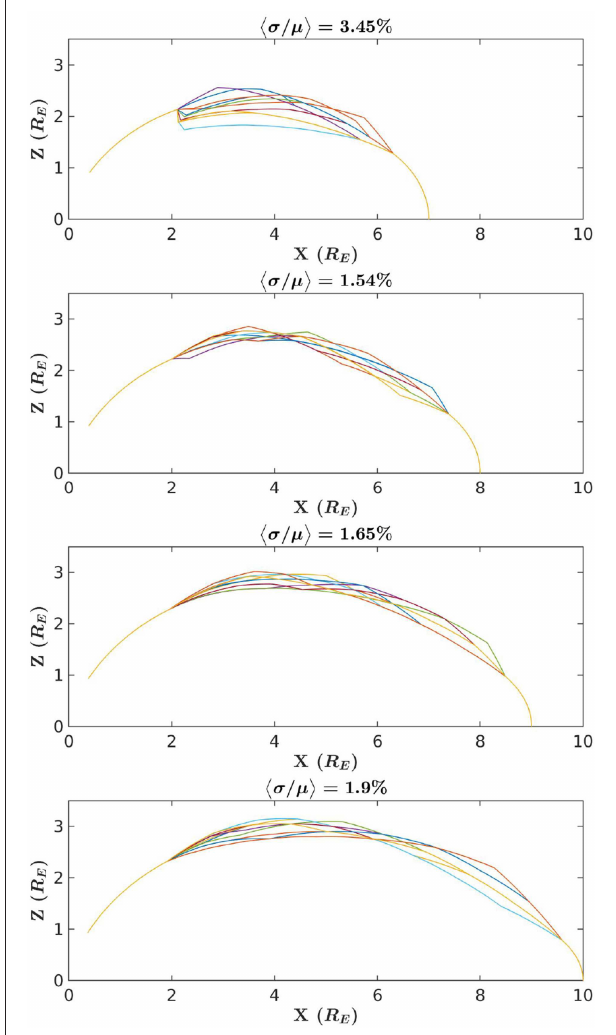
FIGURE 9 | Comparison between T89 field-lines and curves generated via the brute force implementation of the method, where the particular curve that was picked has the least < f ′′ > . Each panel is an example comparison where a different launch point was selected. Above each example is a percent error, here computed from the mean difference between f and the T89 curve divided by the mean averaged over θ .